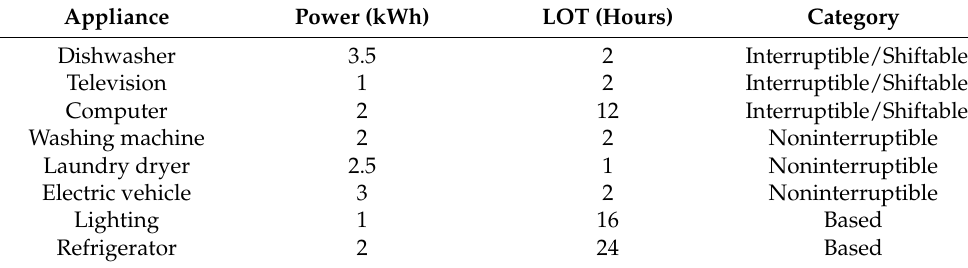
Table 3. Parameters of